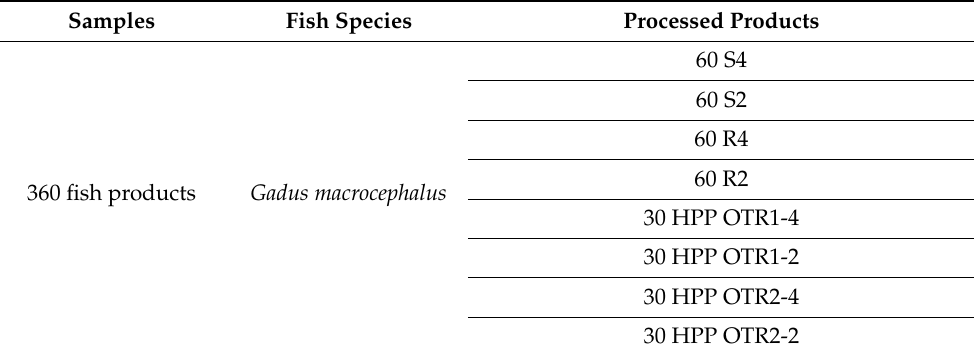
Figure 1. Article flowchart. Prp: prerequisite; CCP: critical control point. Table 1. Samples included in the present